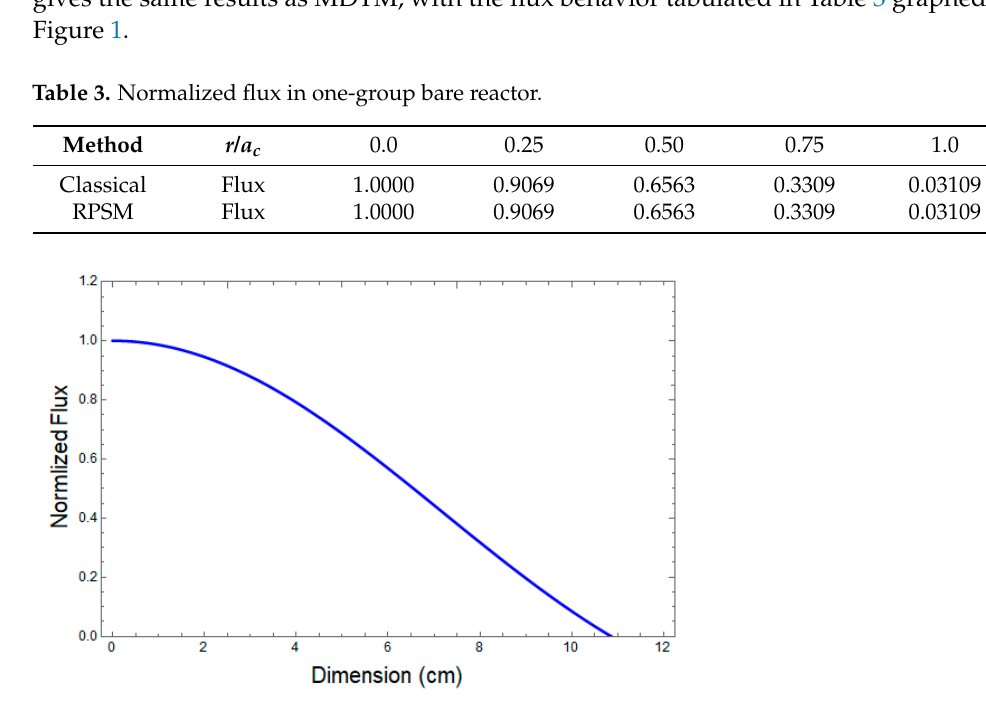
Figure 1. Flux distribution in one ‐ group bare reactor.